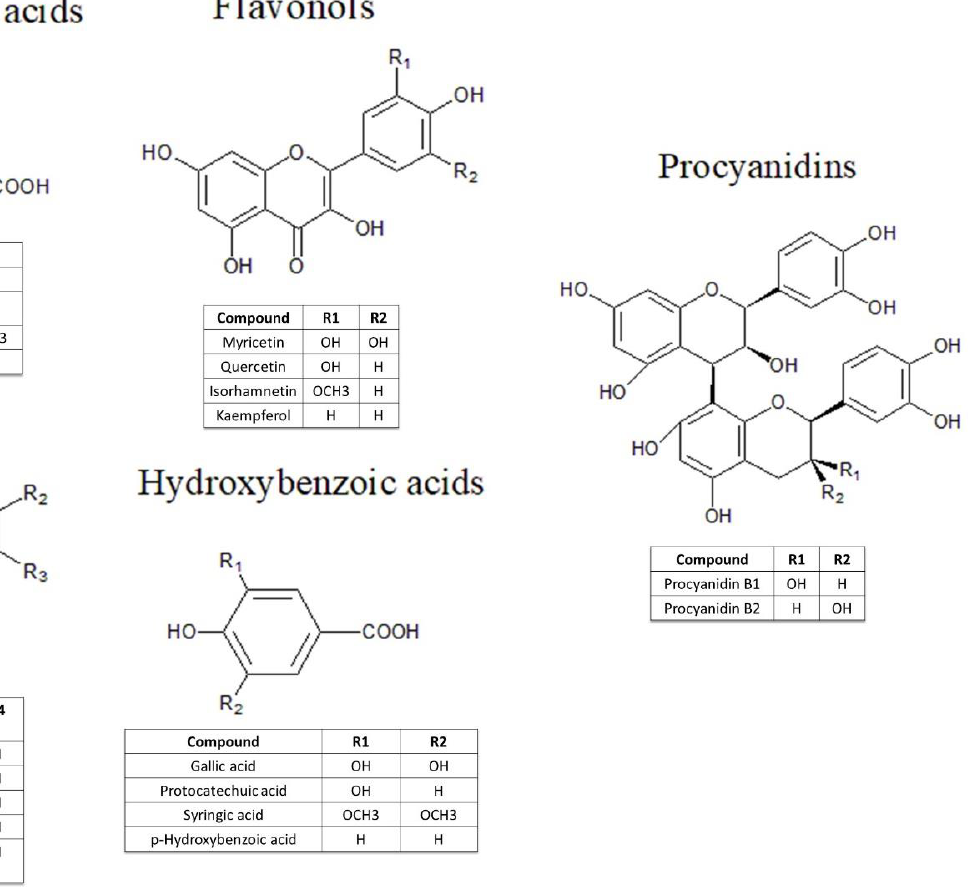
Figure 2. The chemical composition of principal polyphenols from grape pomace.